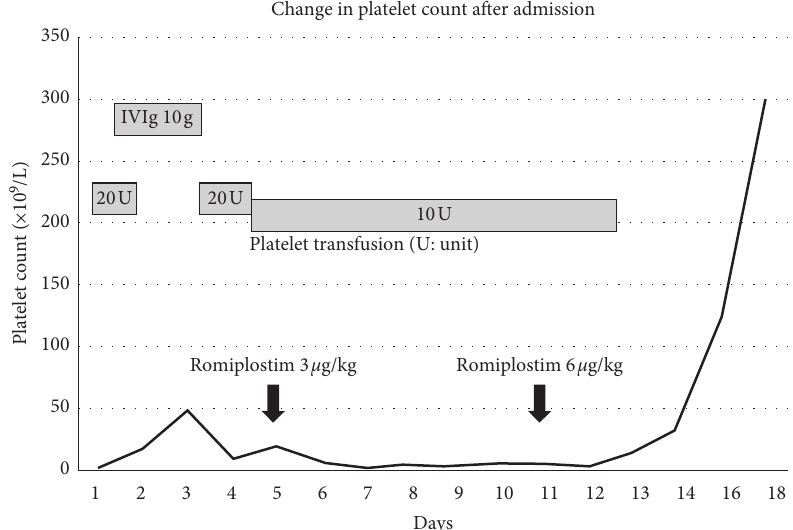
Figure 1: Change in platelet count after admission. The patient underwent treatment with platelet transfusion, high-dose intravenous gamma-globulin (IVIG), and romiplostim. Platelet counts increased about 14 days after